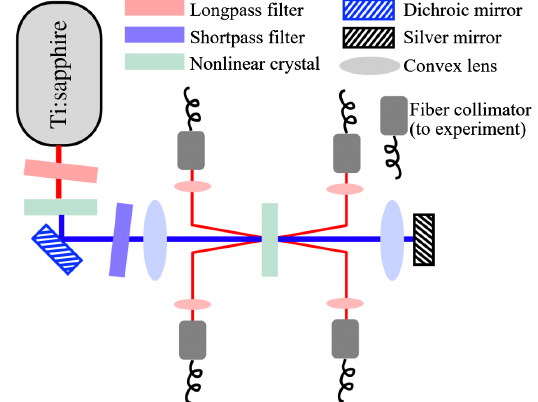
FIG. 7. Schematic of our double-pass SPDC source. The pump (blue) is retroreflected to make a second pass through the BBO